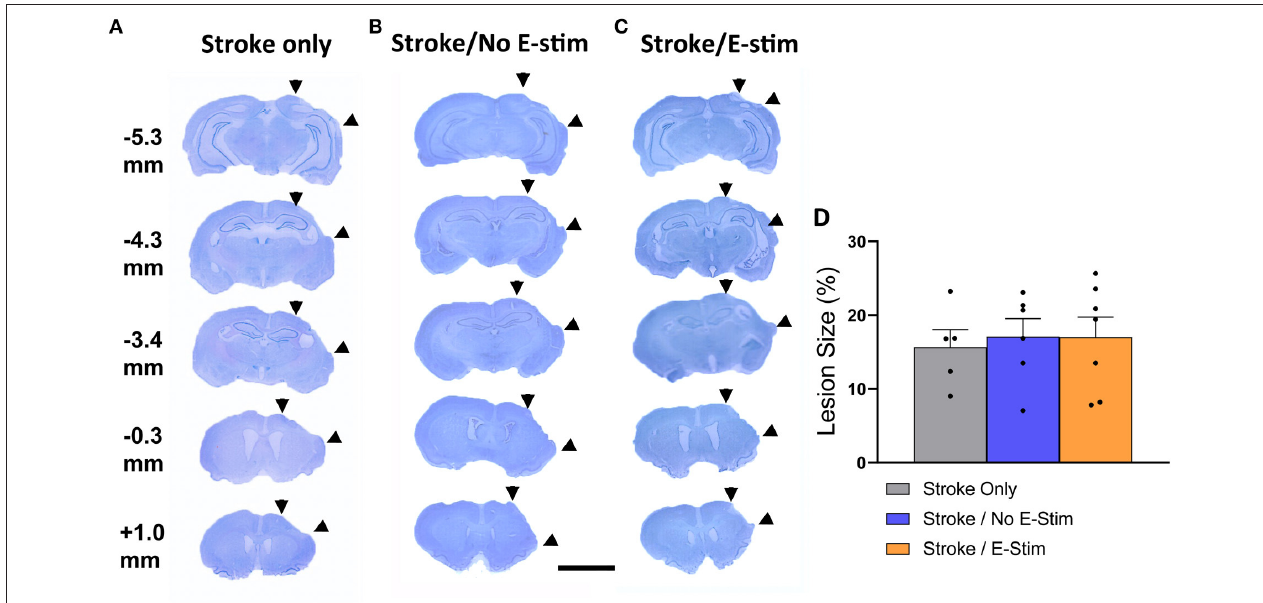
FIGURE 3 | Lesion analysis. Nissl stain sections and their relative distance from bregma showing typical ischemic lesion of all three groups of rats (A–C) . Area between two arrowheads on each brain section indicates stroke-induced necrotic regions. The numbers indicate relative distance to bregma. The scale bar indicates 0.5cm. (D) Lesion analysis showed no difference in the lesion size between groups (Stroke only vs. Stroke/No e-stim vs. Stroke/E-stim ANOVA, p >